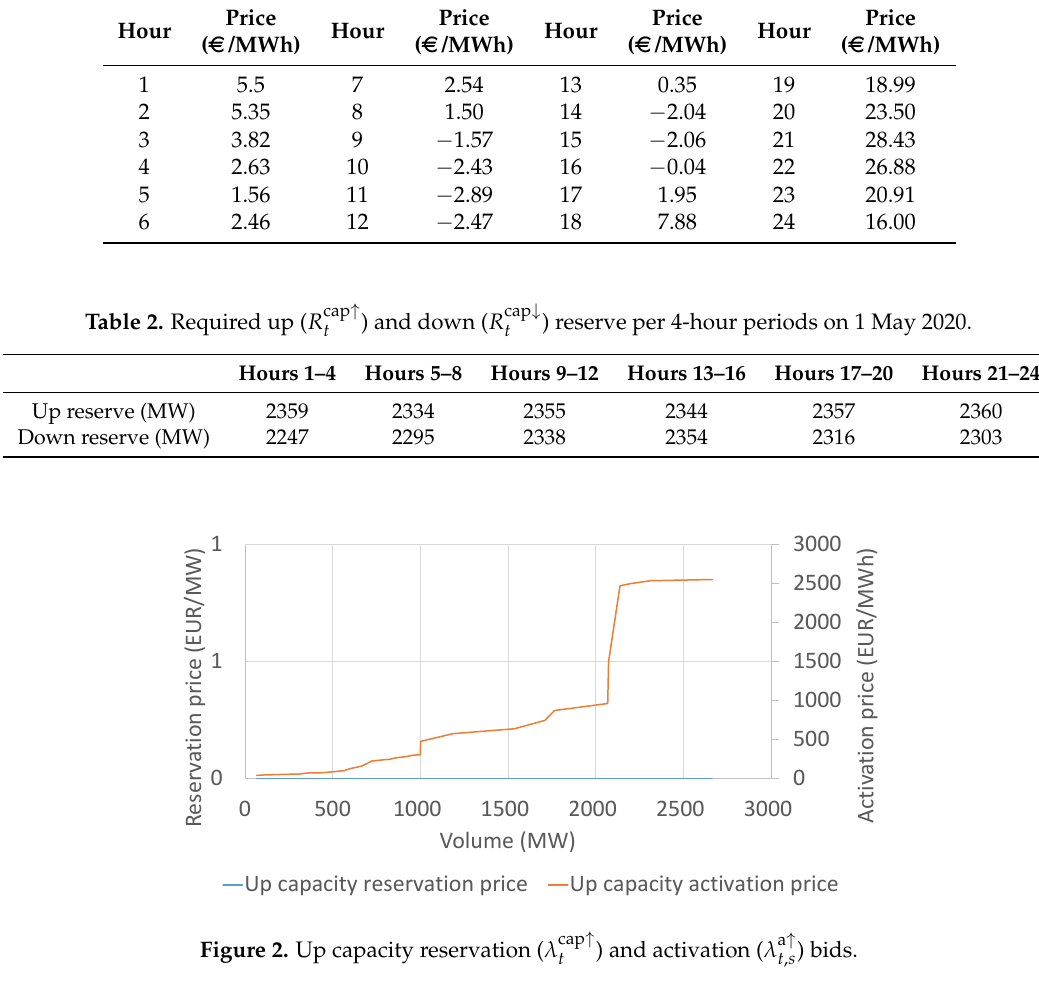
) on 1 May 2020. t